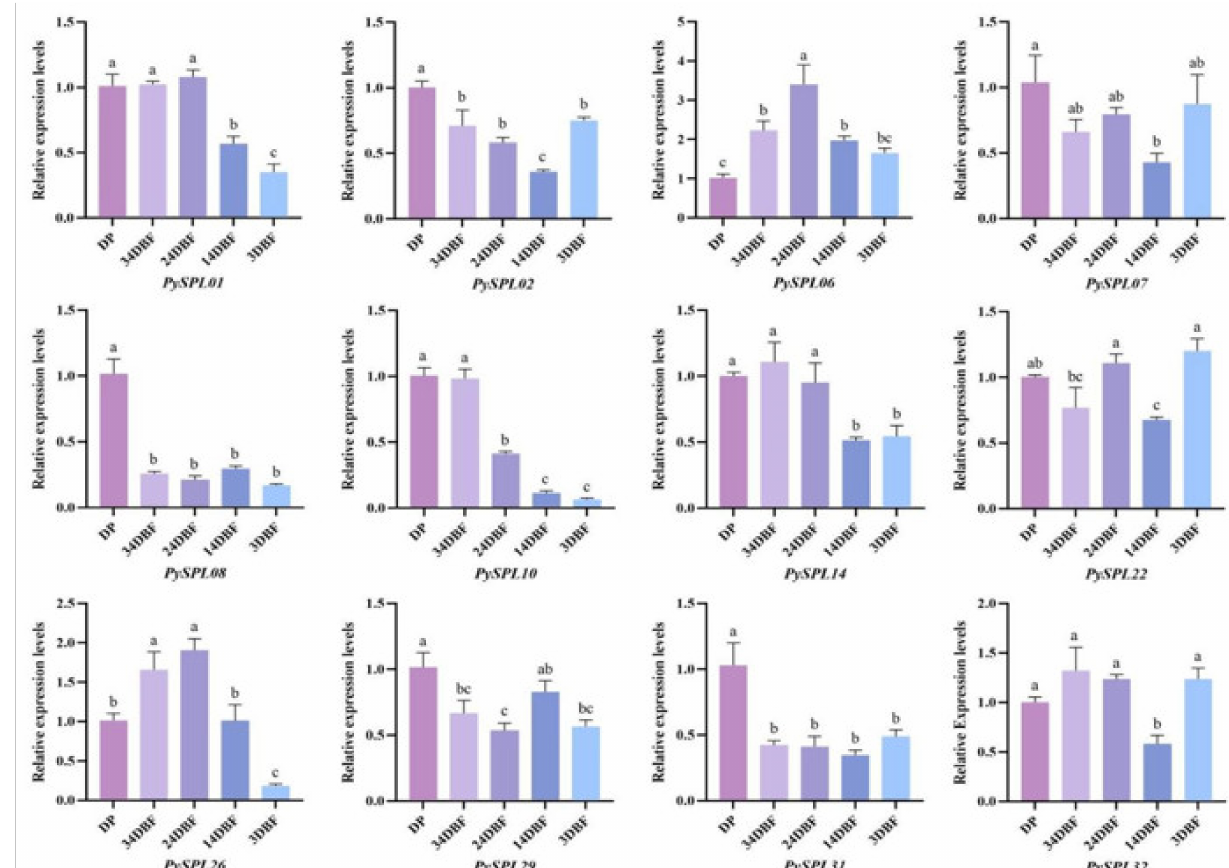
Figure 8. Expression of PySPLs in flower buds at different flower developmental stages in Prunus × yedoensis ’Somei-yoshino’ by qRT-PCR. DP:dormant period,34DBF:34 day before flowering, 24DBF:24 day before flowering,14DBF:14 day before flowering, 3DBF:3 day before flowering. Each value is shown as average ± standard deviation from three biological replicate sampling. p < 0.05 for significance. a, b, c and d represent the level of significant difference between different samples, the difference between samples with the same letter is not significant; the greater the difference of letters, the more significant the difference between